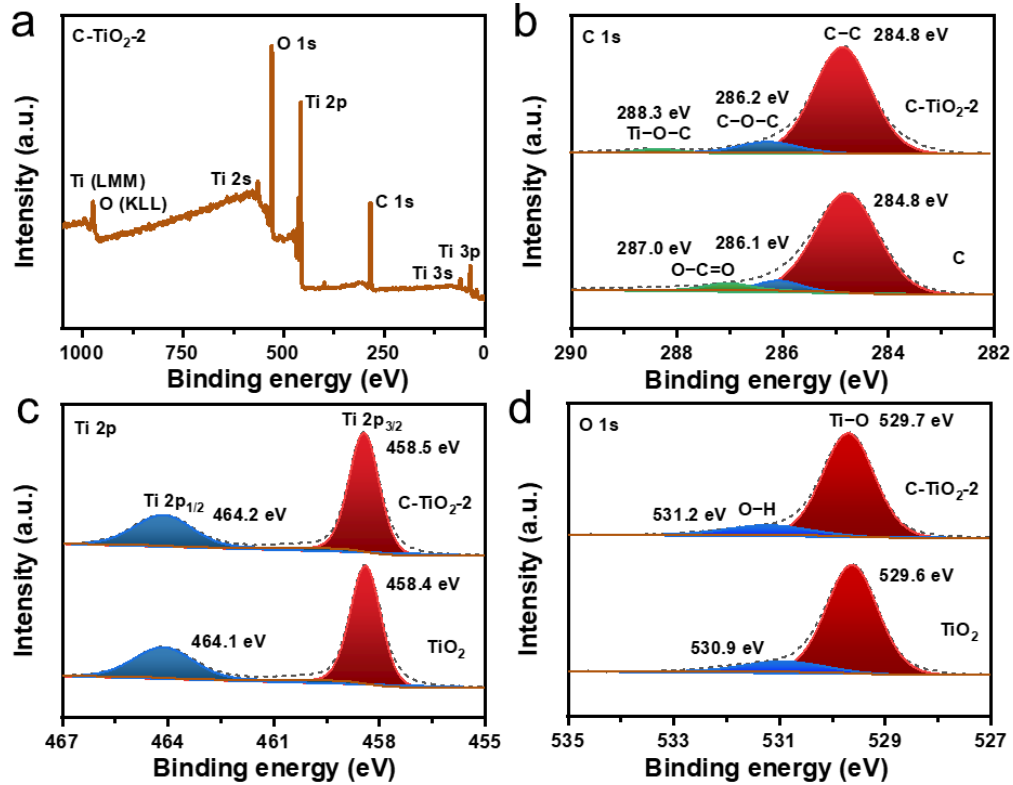
Figure 4. ( a ) XPS survey spectra of the prepared C − TiO 2 − 2. ( b ) C 1s XPS spectra of the C and C − TiO 2 − 2. ( c ) Ti 2p XPS spectra of the TiO 2 and C − TiO 2 − 2. ( d ) O 1s XPS spectra of the TiO 2 and C − TiO 2 − 2.